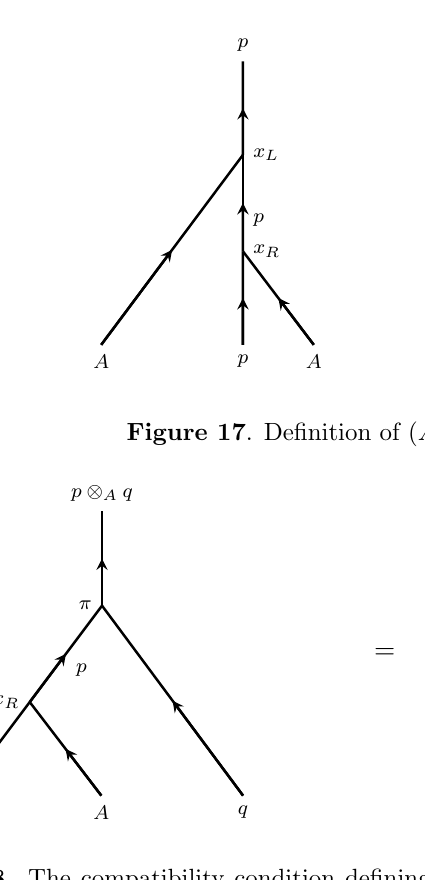
Figure 18 . The compatibility condition de(cid:12)ning balanced tensor product of two A -bimodules p and q via (cid:25)